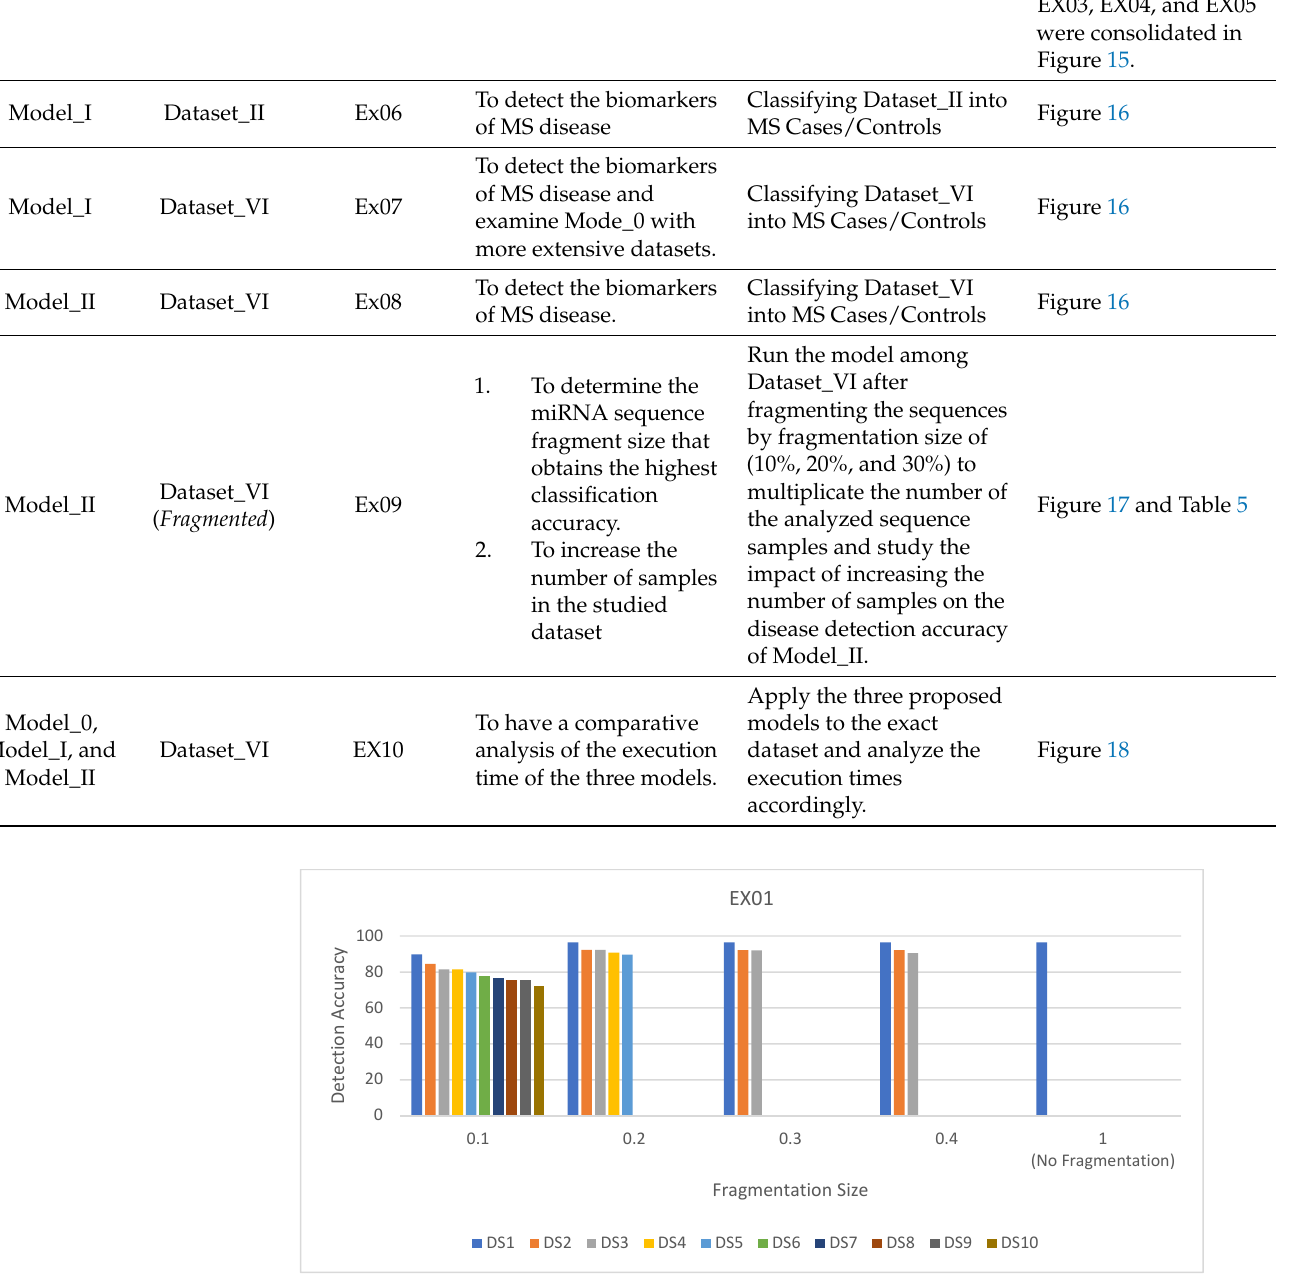
Figure 9. Examining each sub-dataset (DS n ) and determining the biomarker detection accuracy of each sub-dataset. Fragmentation size f = {0.1, 0.2, 0.3, and 0.4} were applied to determine which sub-dataset DS n has the highest accuracy scores of biomarker detection.